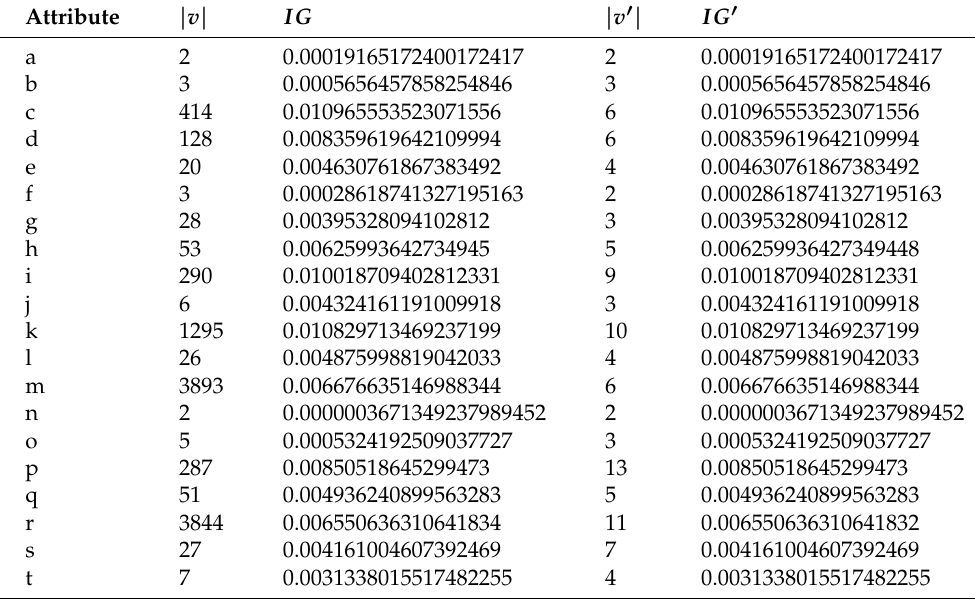
Table 8. The categorical attributes and their IG from Dataset 2.